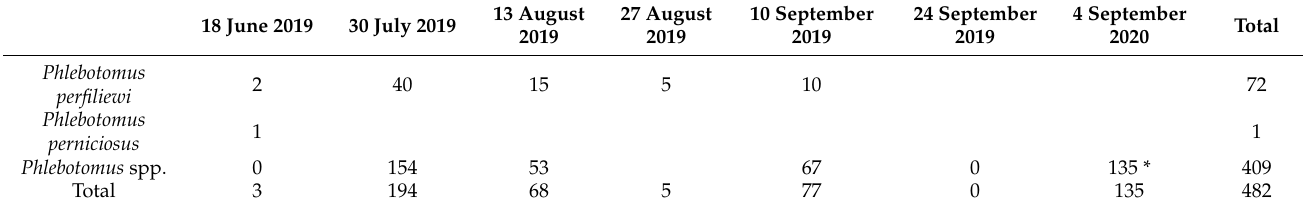
Table 1. Sandflies species composition in Casalgrande